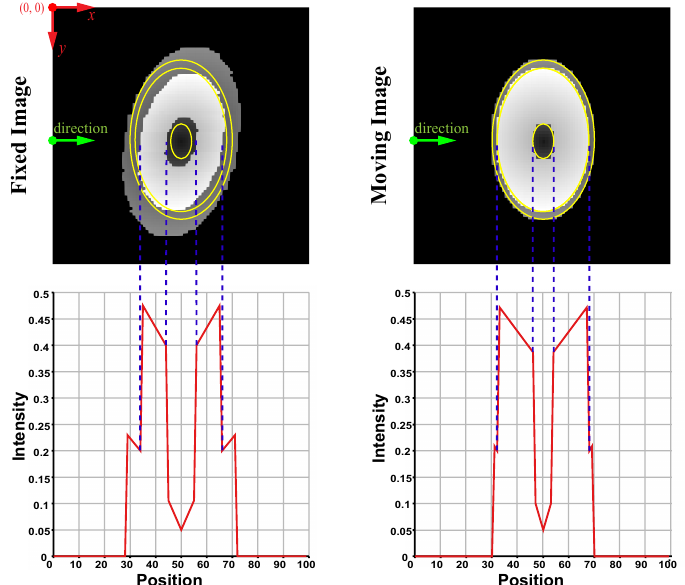
Figure 3. The synthetic 2D data in Section 3.2 is shown. The first row displays the moving and fixed images. The boundaries of the fixed image are marked with yellow outlines. The second row plots the images of the intensity value on the line segment from ( 0,50 ) to ( 99,50 ) , which is the direction of the green arrows.